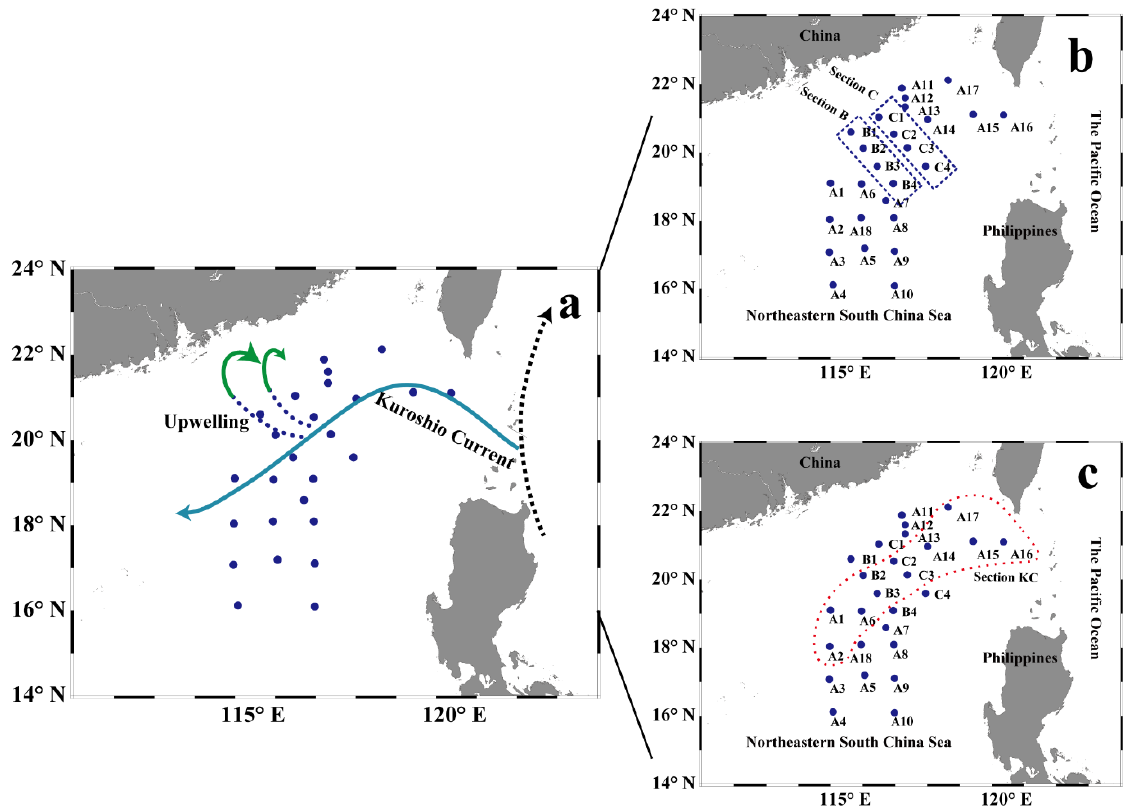
Figure 1. Stations sampled in northeastern South China Sea (NESCS). (( a ): the appropriate locations of the different currents are described according to Shu et al. [21]; ( b ): The blue dotted lines show sampling sections defined as Section B, Section C; ( c ): The red dotted lines show sampling sections defined as Section KC.).